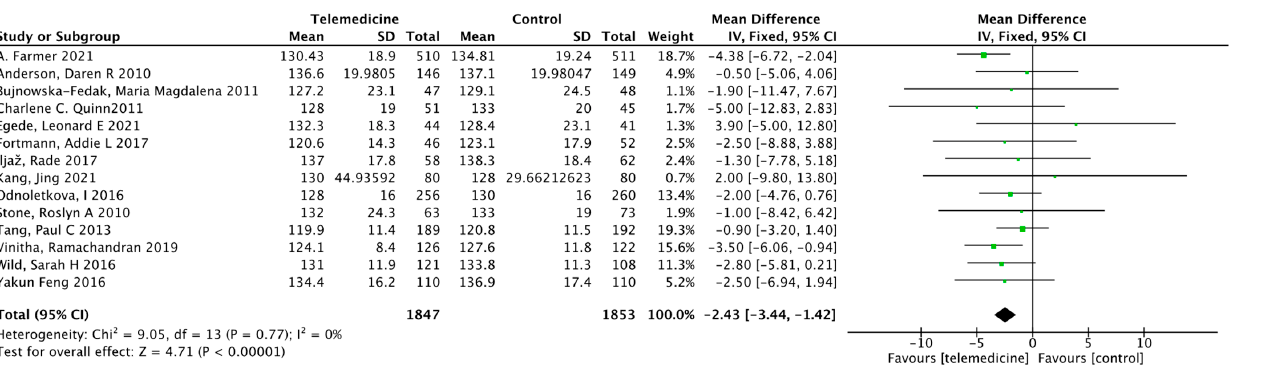
Figure 9. Mean difference in the changes in SBP levels for telemedicine and usual care interventions. Effects on High-Density Lipoprotein, Low-Density Lipoprotein, Triglycerides, and Total